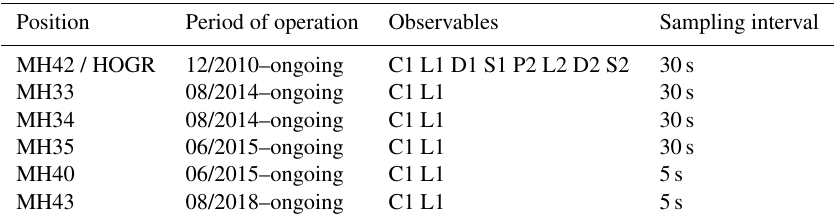
Table 5. Details of GNSS observation periods and